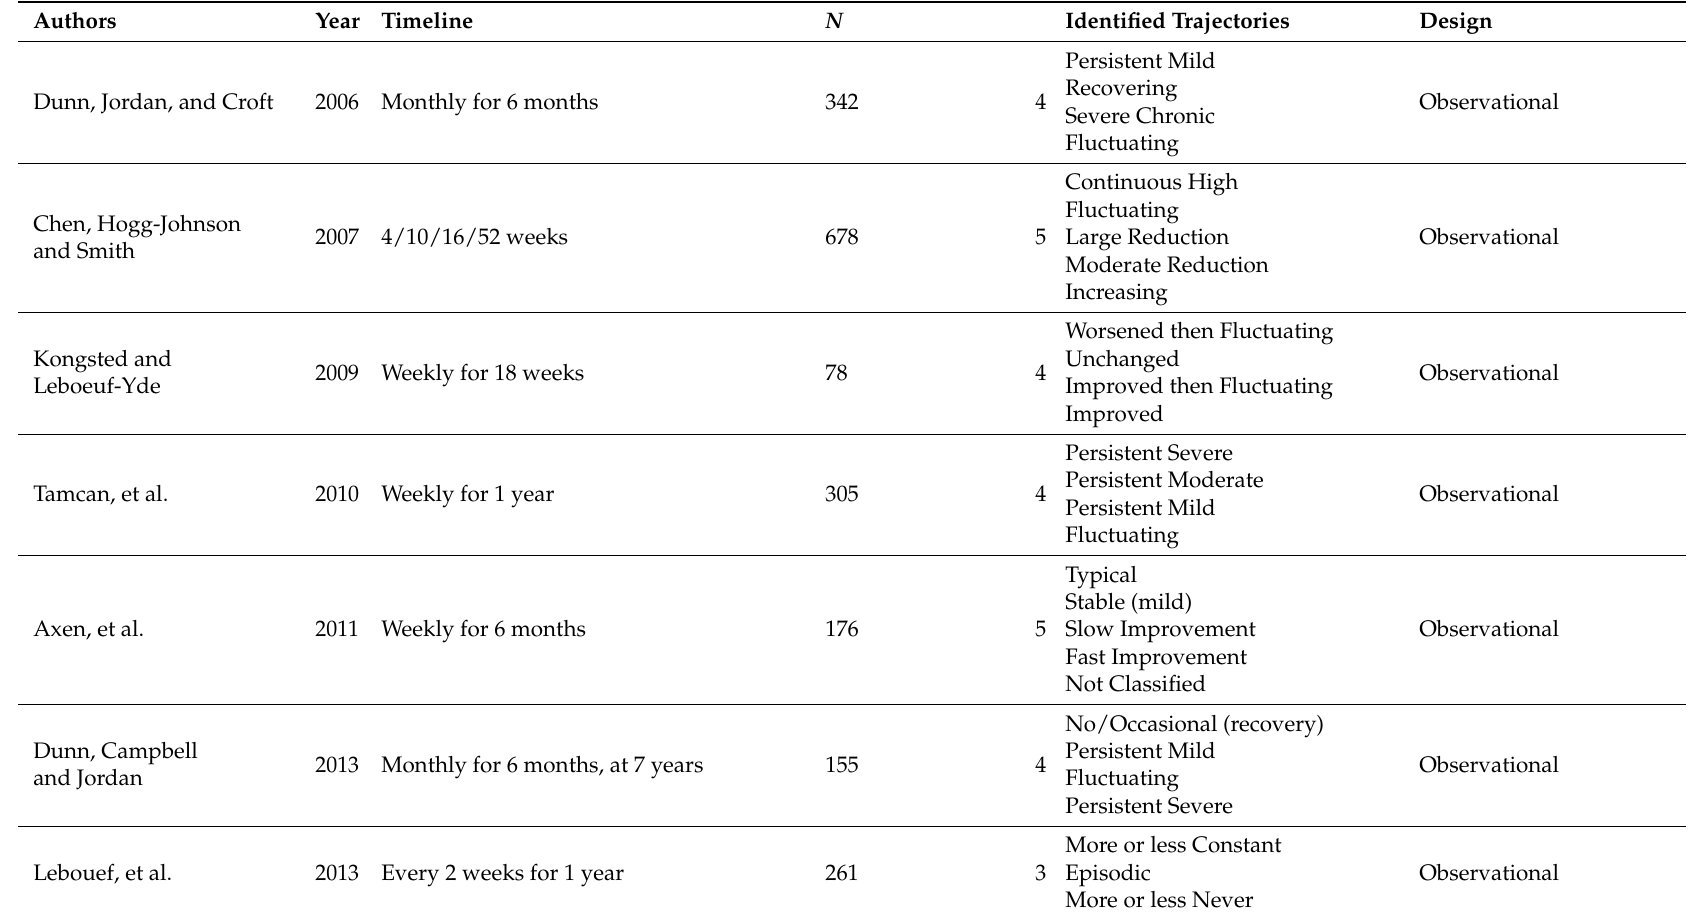
Table 1. Trajectory Classification by Reference